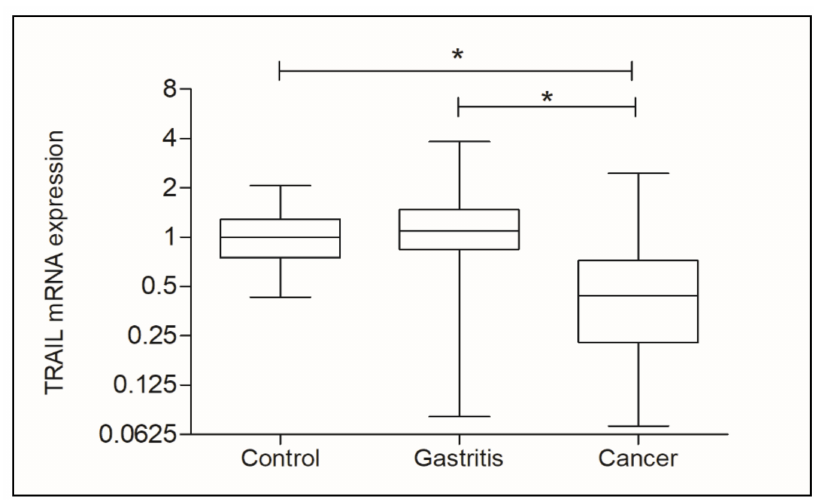
Figure 2. Analysis of TNF-related apoptosis-inducing ligand ( TRAIL ) gene expression in Control, Gastritis, and Cancer groups, considering patients that were positive and negative for H. pylori infection in all groups. * statistically significant.